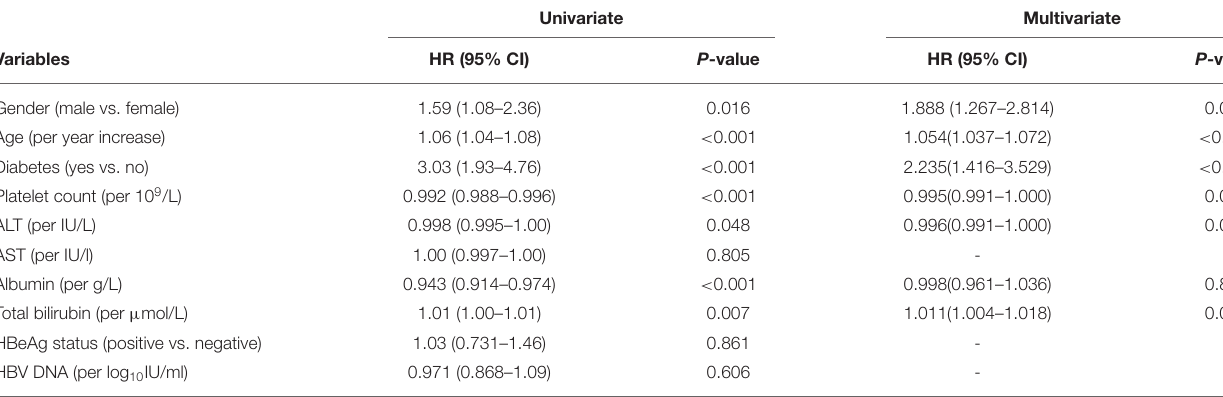
TABLE 2 | Predictors of HCC development.